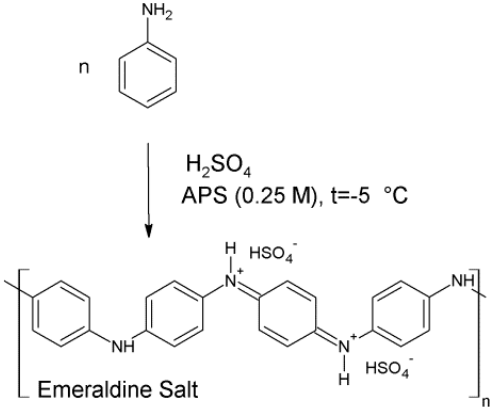
Figure 1. Oxidative polymerization of aniline with ammonium peroxydisulfate (APS) initiator during modified rapid mixing procedure.